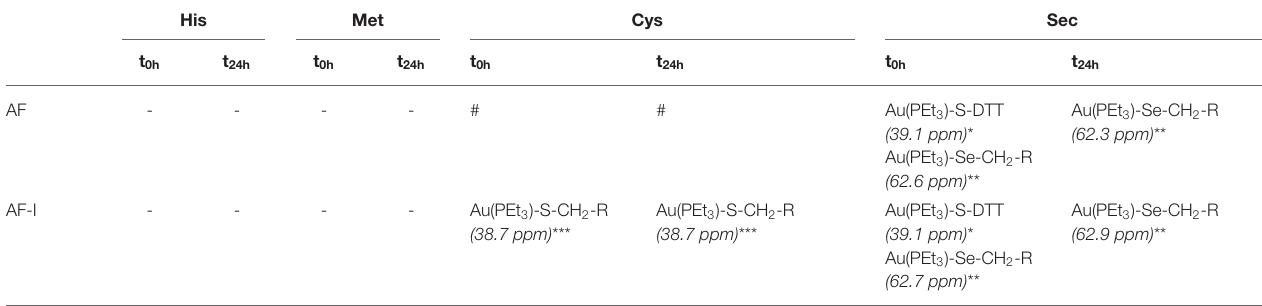
TABLE 1 | Results obtained by 31 PNMR experiments for the incubation at different time intervals ( t = 0 and t = 24h) of AF and AF-I with His, Met, Cys, or Sec. His